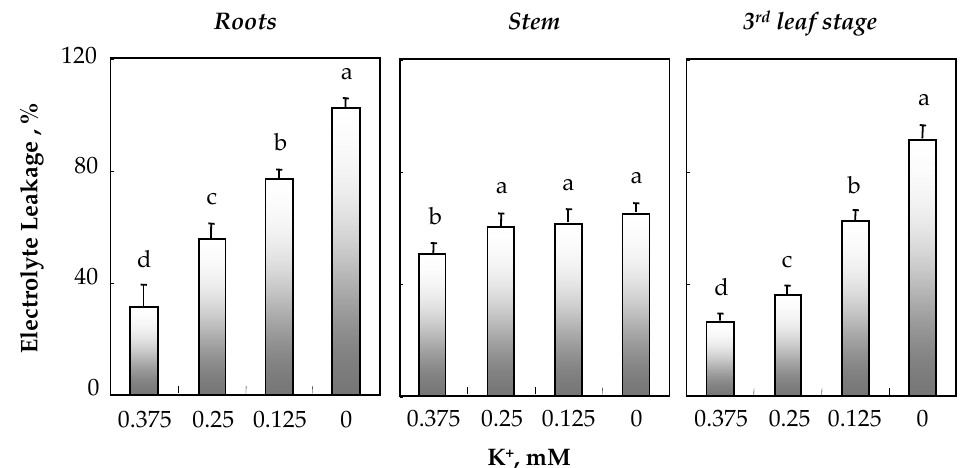
Figure 5. Variations in electrolyte leakage (EL) in roots, stem and the third leaf stage of 64-day-old O. basilicum plants grown for 30 days in the presence of varying K + concentrations (0.375, 0.25, 0.125 and 0 mM). Cf. leg. Figure 2.